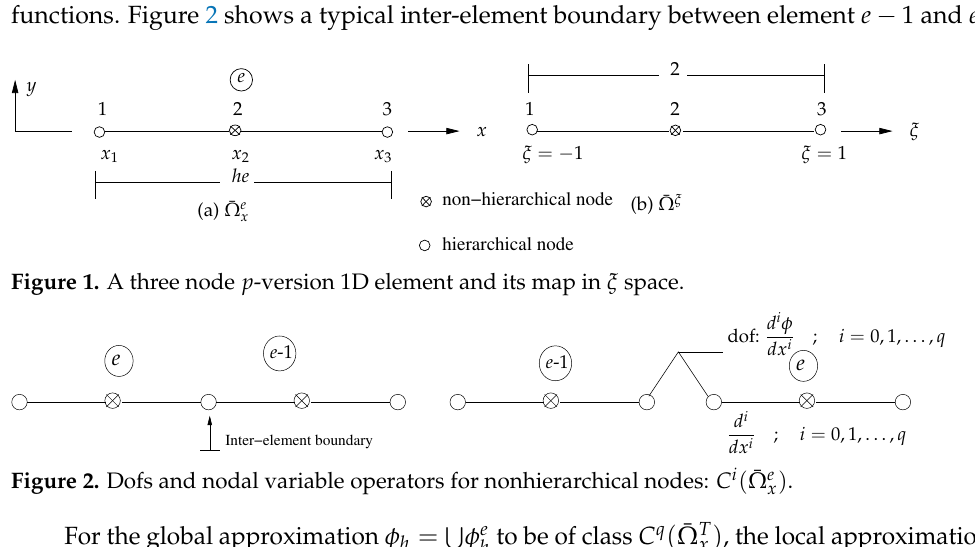
φ e to be of class C q ( ¯ Ω T h e ) , i.e., the union of local approximations φ e x